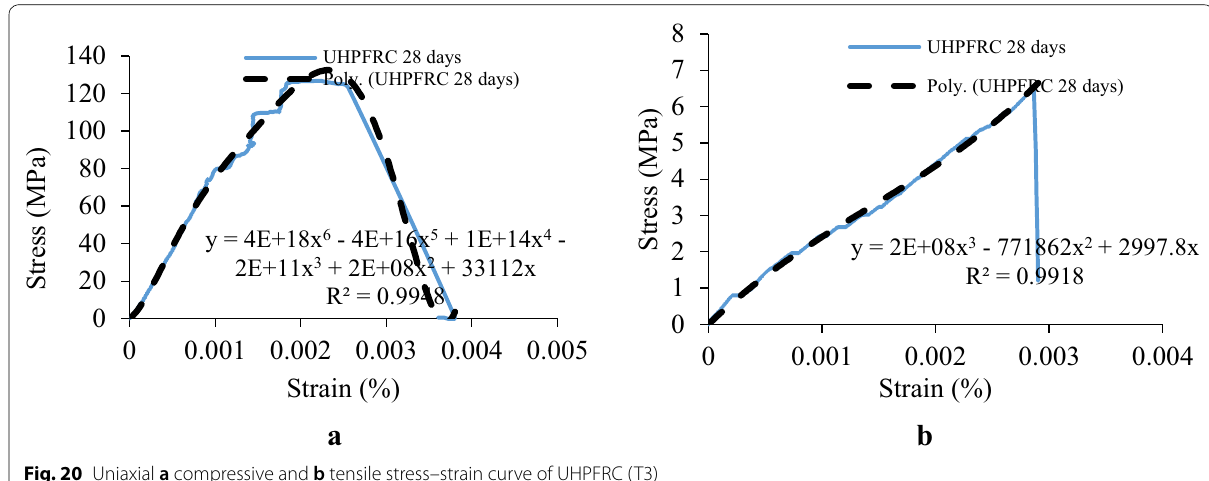
Fig. 20 Uniaxial a compressive and b tensile stress–strain curve of UHPFRC (T3)